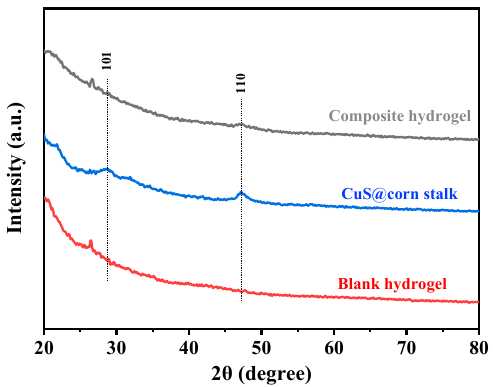
Figure 4. XRD patterns of CuS@corn stalk /chitin composite hydrogel, CuS@corn stalk and blank hydrogel.